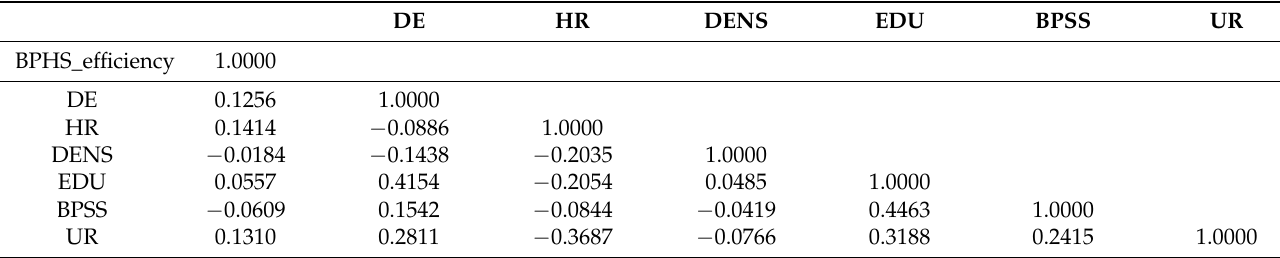
Table 7. Correlation test